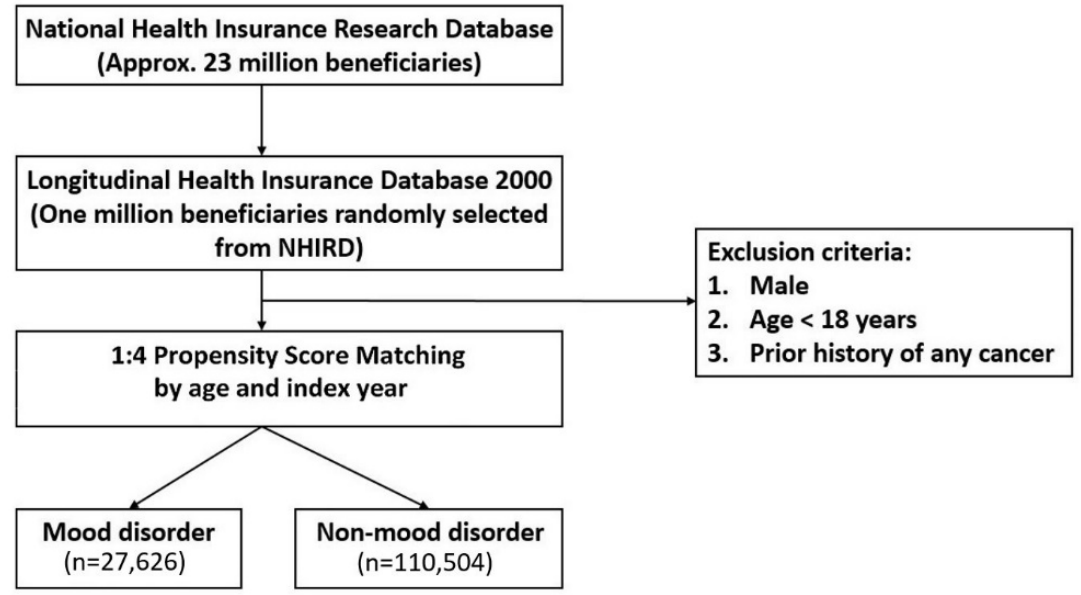
Figure 1. Study flowchart. The flowchart shows the subject selection in this study.